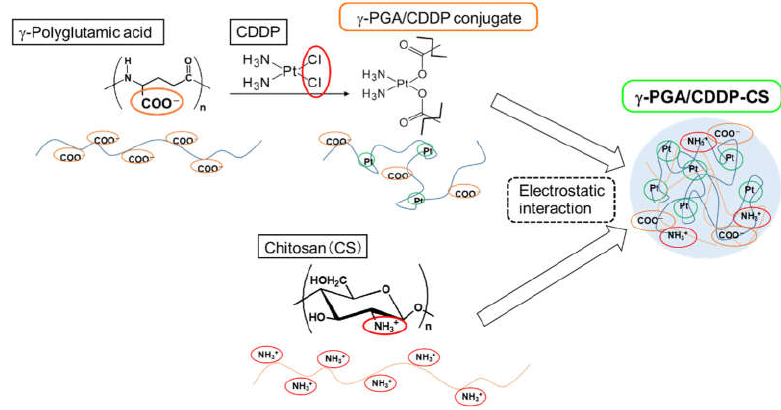
Figure 1. Schema of synthesis of γ−PGA/CDDP−CS.